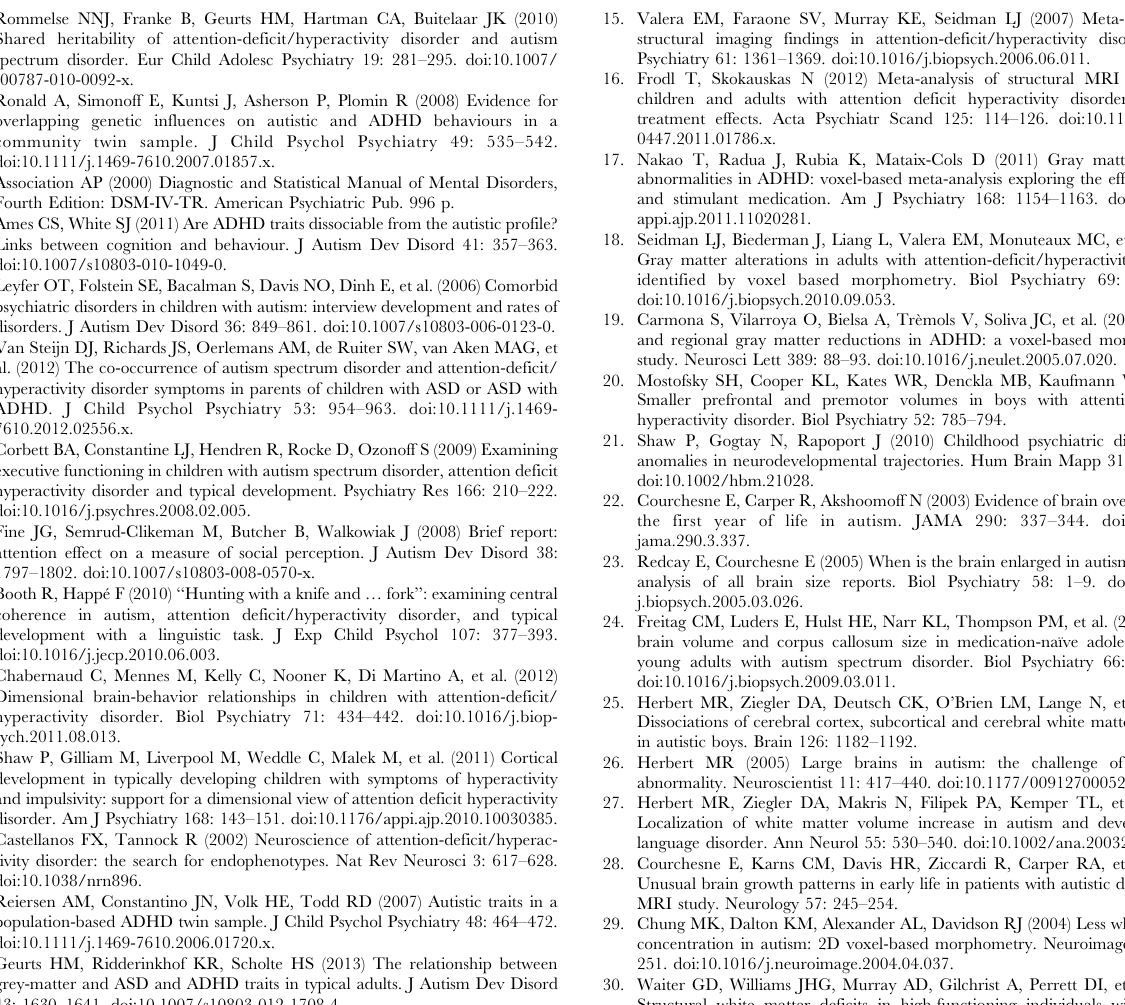
Table S4 Final, generalised mixed-effect model for ASD score modelled against Grey Matter Residual and White Matter Volumes. Table S5 Final, generalised mixed-effect model for ASD score modelled against Grey Matter and White Matter Volumes using only participants with an ASD score of 20 or higher. Diagnostic Algorithm S1 Diagnostic algorithm for ADHD in the NeuroIMAGE